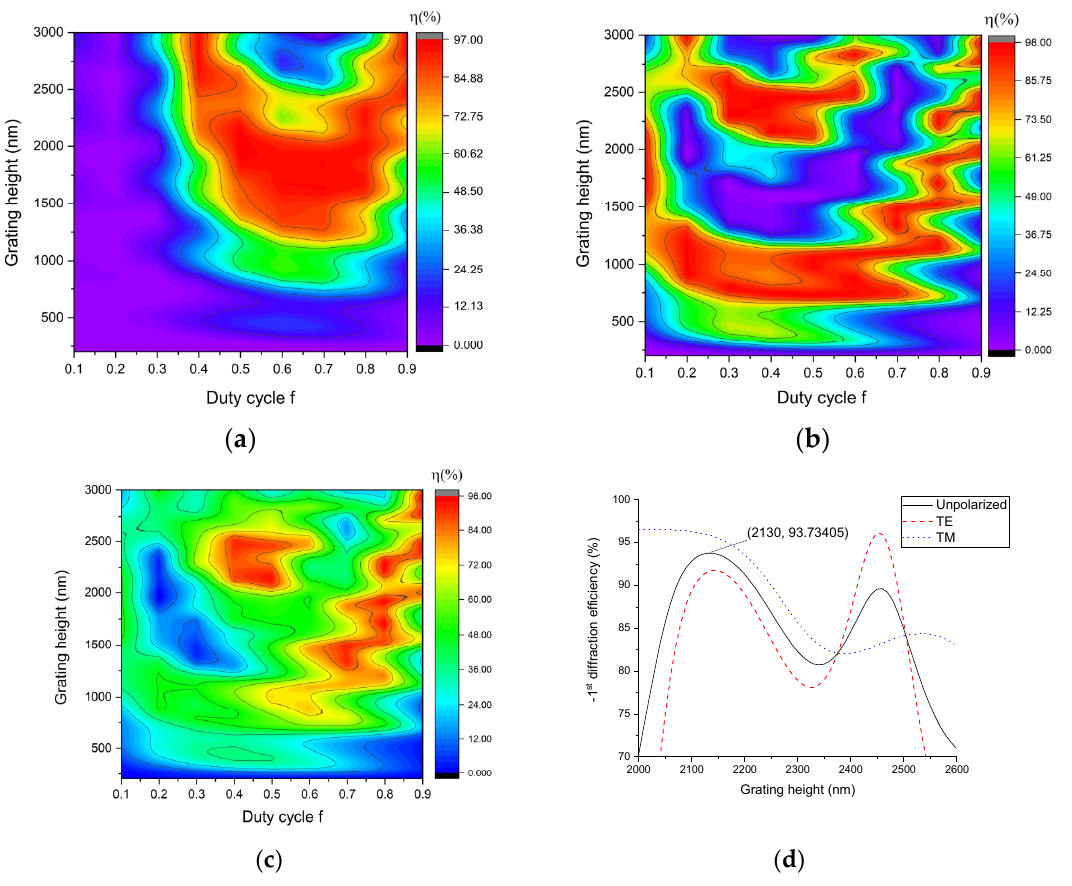
Figure 3. The −1st diffraction efficiency of rectangular−shaped grating for ( a ) TM polarization, ( b ) TE polarization, ( c ) unpolarized light, and ( d ) unpolarized light at f = 0.5. Table 1. Rectangular shaped grating parameters.